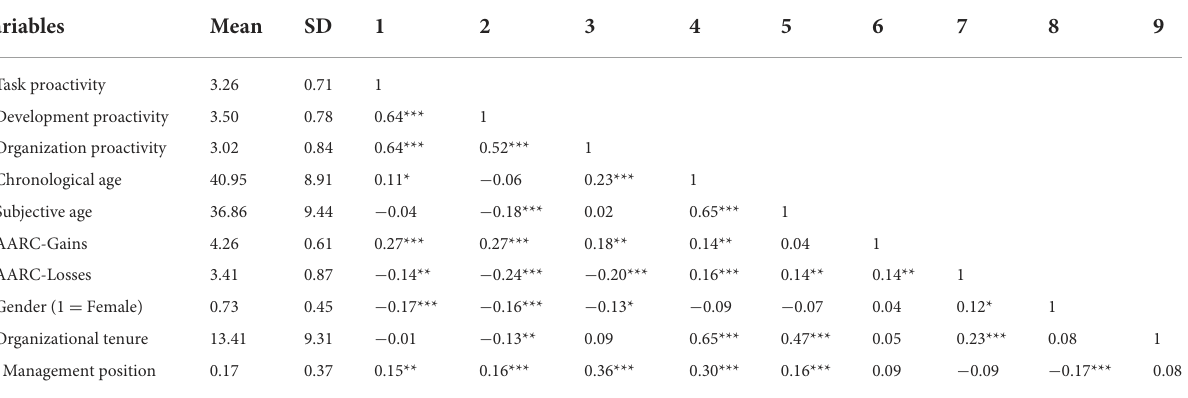
TABLE 4 Mean, standard deviation (SD) and correlations for main study